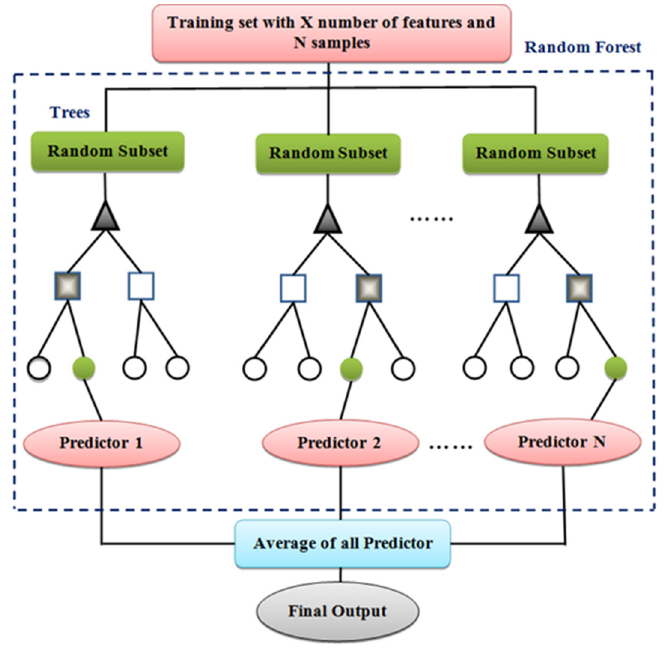
Figure 7. BGER method for prediction.